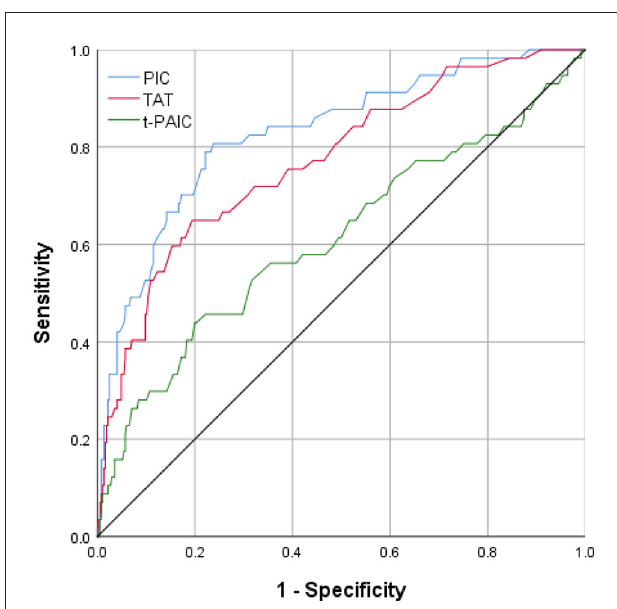
FIGURE2 The area under ROC curve of the levels of plasma PIC, TAT, and t-PAIC in patients with AIS prediction of